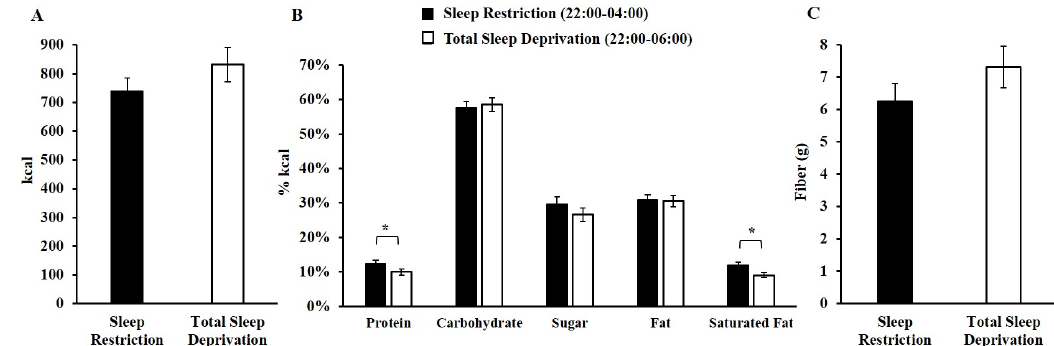
Figure 2. Mean ± SEM late ‐ night intake during sleep restriction (SR) and total sleep deprivation (TSD). ( A ) Late ‐ night caloric intake during SR and TSD did not significantly differ ( p = 0.12); ( B ) During late ‐ night hours, participants consumed a significantly larger percentage of calories from protein (* p = 0.01) and saturated fat (* p = 0.02) during SR, but there were no differences in carbohydrate, sugar, fat, or fiber ( C ) intake ( p ’s > 0.17).